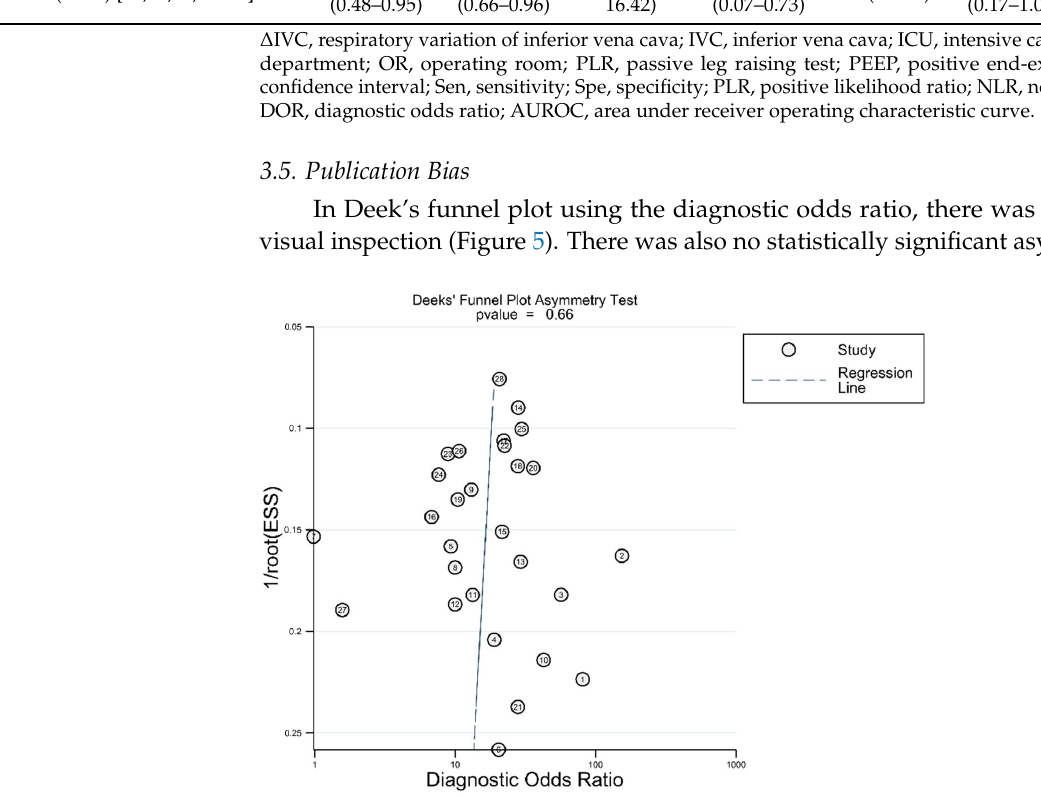
Figure 5. Asymmetry test for publications